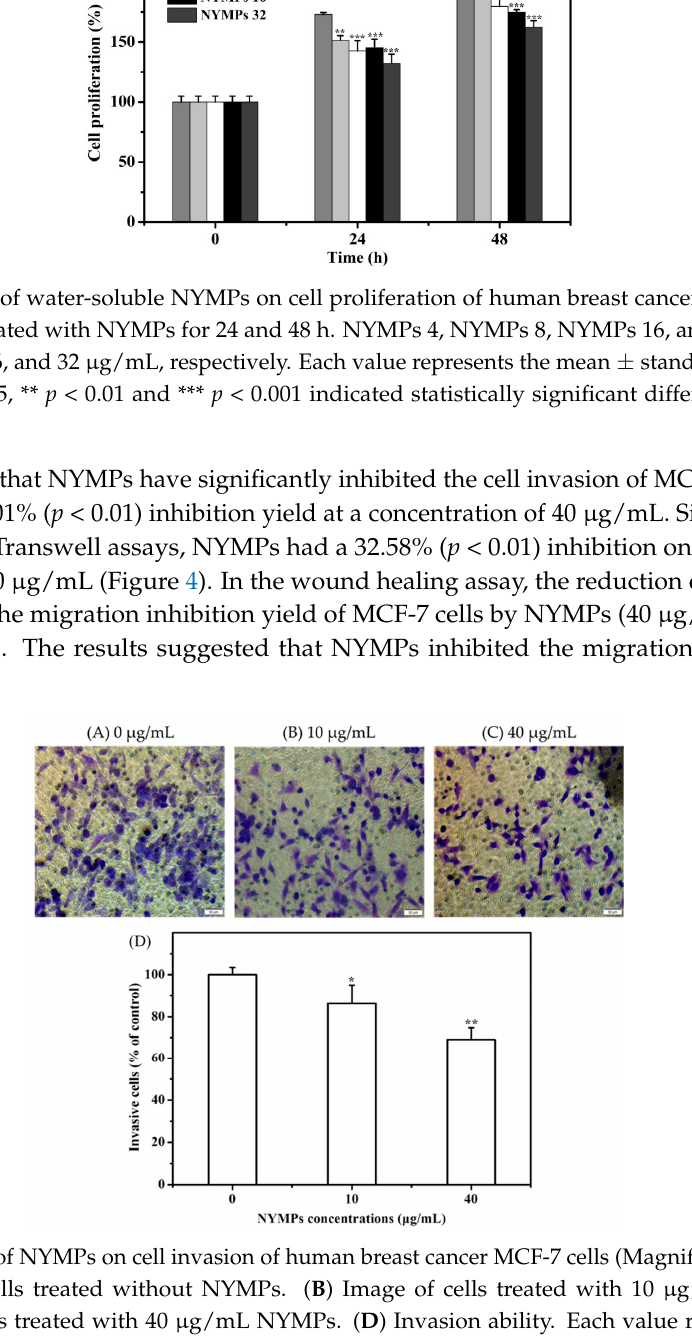
Figure 1. Cytotoxicity of water-soluble NYMPs on human breast cancer MCF-7 cells under different concentrations. Each value represents the mean ± standard deviation ( n = 3).